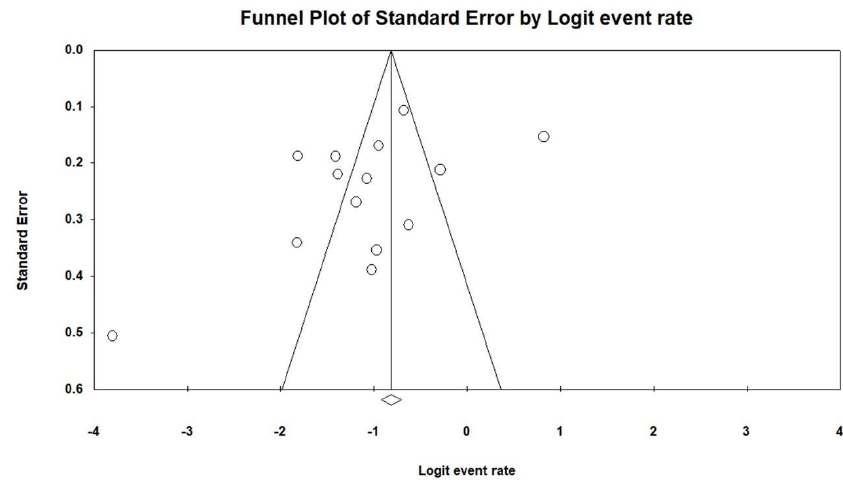
Figure 3. Funnel plot for the log-transformed point estimates of the prevalence among the included studies.